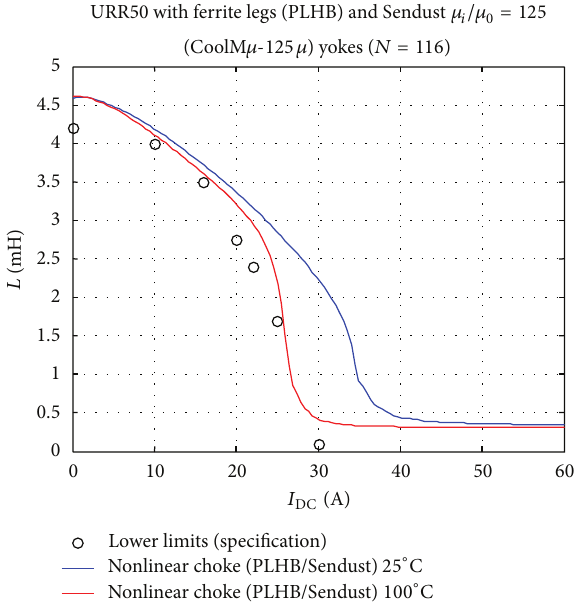
Figure 9: Inductance curves of the optimized nonlinear (saturable) inductor meet specification at 25 ∘ C as well as 100 ∘ C.